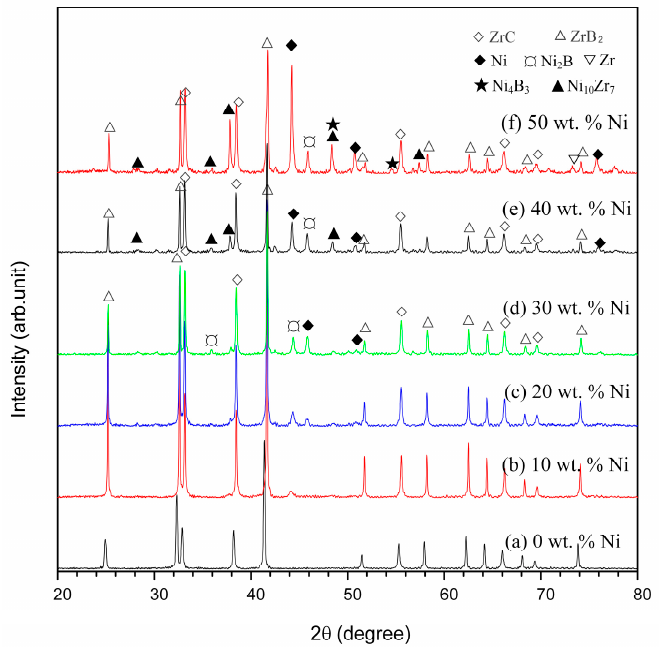
Figure 6. XRD patterns for the SHS products with different reactant Ni contents in Ni-Zr-B 4 C system: (a) 0 wt.%, (b) 10 wt.%, (c) 20 wt.%, (d) 30 wt.%, (e) 40 wt.%, and (f) 50 wt.%.